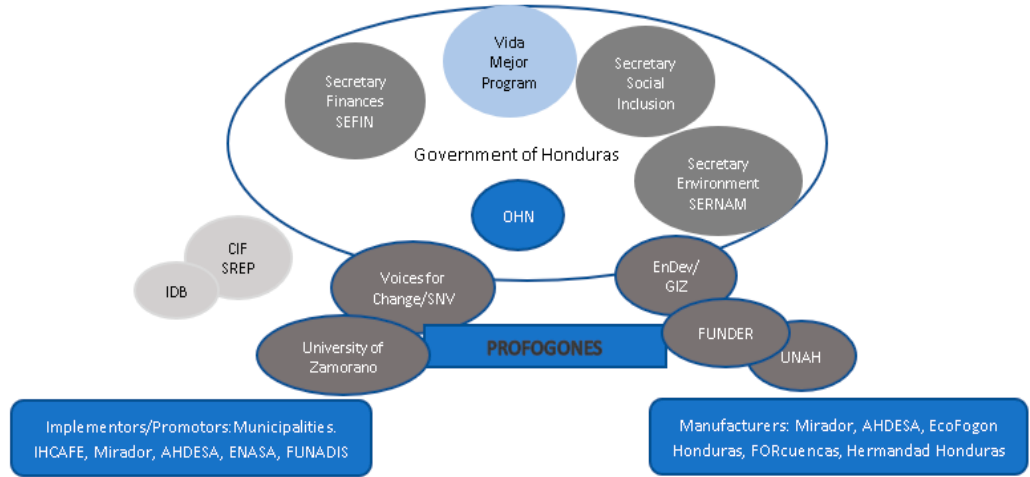
Figure 3. Stakeholder mapping of the clean cookstove sector in Honduras (modified from [9]).